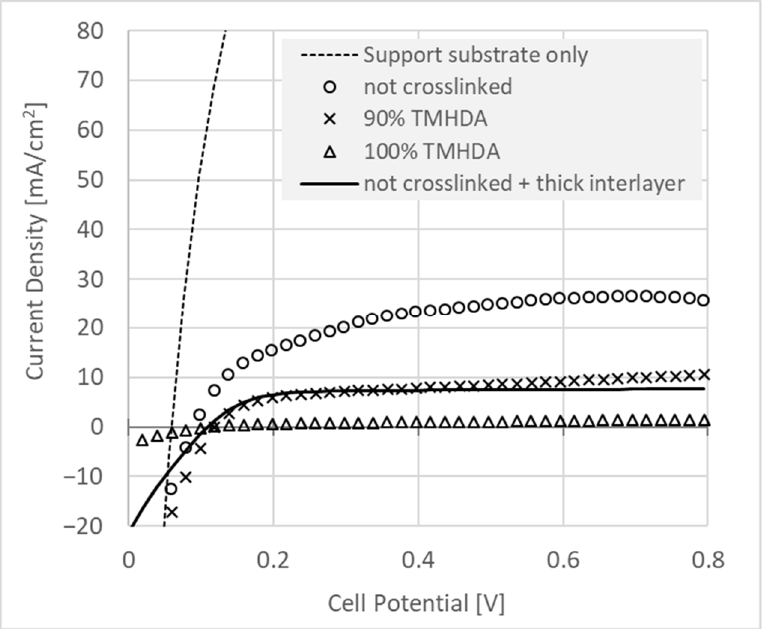
Figure 7. Hydrogen crossover measurement versus layer thickness. For this experiment, an ultra- thin (5 m) reinforced, ionomer-infused support substrate was used as a dummy membrane which provided ionic conductivity between counter and working electrodes without substantially inhibiting hydrogen crossover. This substrate was placed between identical GDE’s, allowing a qualitative evaluation of the membrane-like properties of the interlayers. The crossover of the “support substrate only” (dashed line) was measured with interlayer-free GDE’s. Interlayer loadings are 0.12 mg/cm 2 , corresponding to <1 micron of interlayer, or 0.5 mg/cm 2 (“thick interlayer”, solid line), on each electrode.